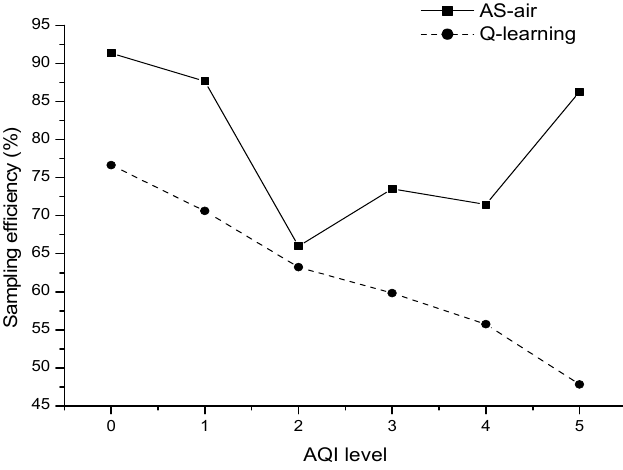
Figure 8. The sampling efficiency with different AQI level.